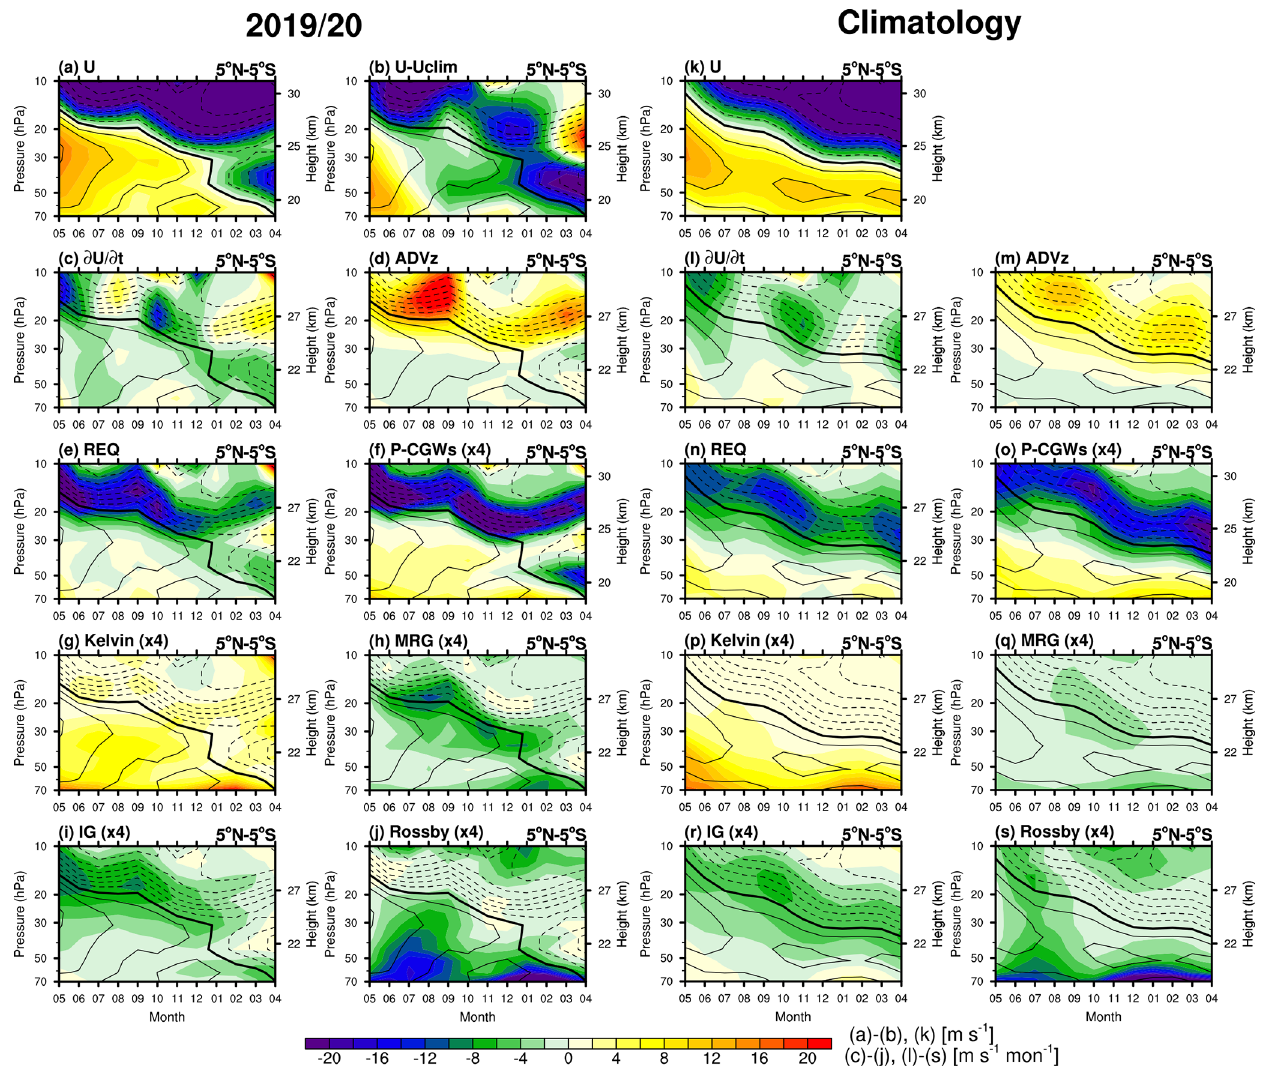
Figure 3. Monthly evolution of the (a) zonal-mean zonal wind ( U ), (b) difference in U between the 2019/20 disruption period and the climatology ( U − Uclim), (c) zonal wind tendency ( ∂U/∂t ), (d) vertical advection (ADVz), (e) required wave forcing (REQ), and EPFD for the (f) P-CG, (g) Kelvin, (h) , MRG, (i) IG, and (j) Rossby waves from May 2019 to April 2020 and (k–s) their climatology from May to April from 70 to 10hPa, superimposed on the zonal-mean zonal wind (black contour lines). The solid (dashed) lines indicate westerly (easterly) winds with an interval of 5ms − 1 , and thick solid lines indicate a zero zonal wind